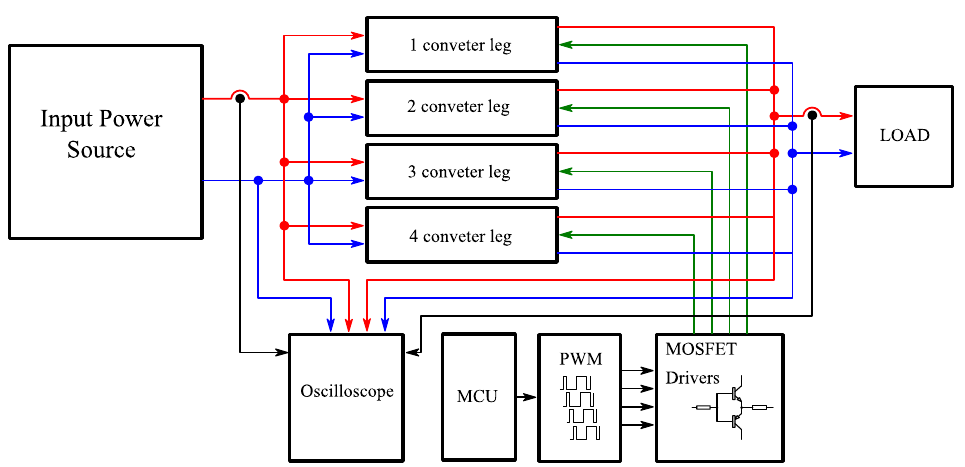
Figure 11. The block scheme of the experimental test.